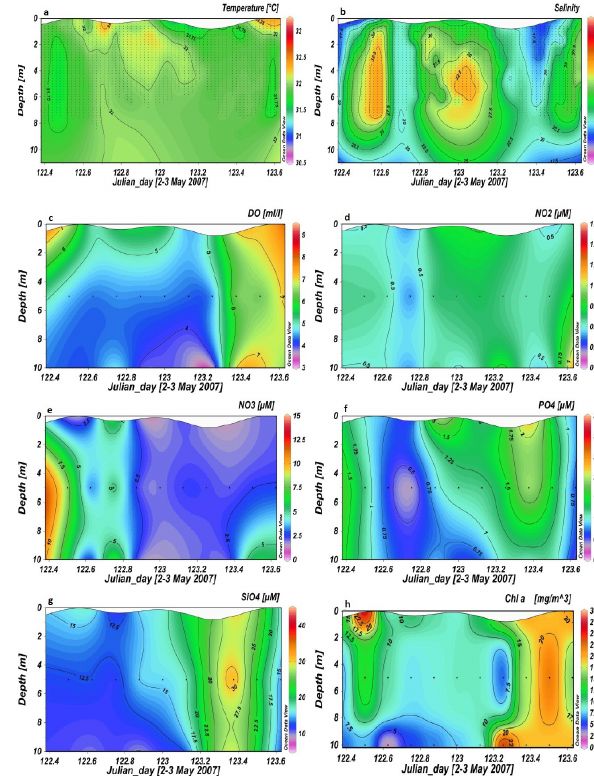
Fig. 4. Depth–time contours of salinity, temperature DO, chloro- phyll a , NO 2 , NO 3 , PO 3 , SiO 4 for every three hours from surface, 4 4 mid-depth and bottom during neap tides of dry season.